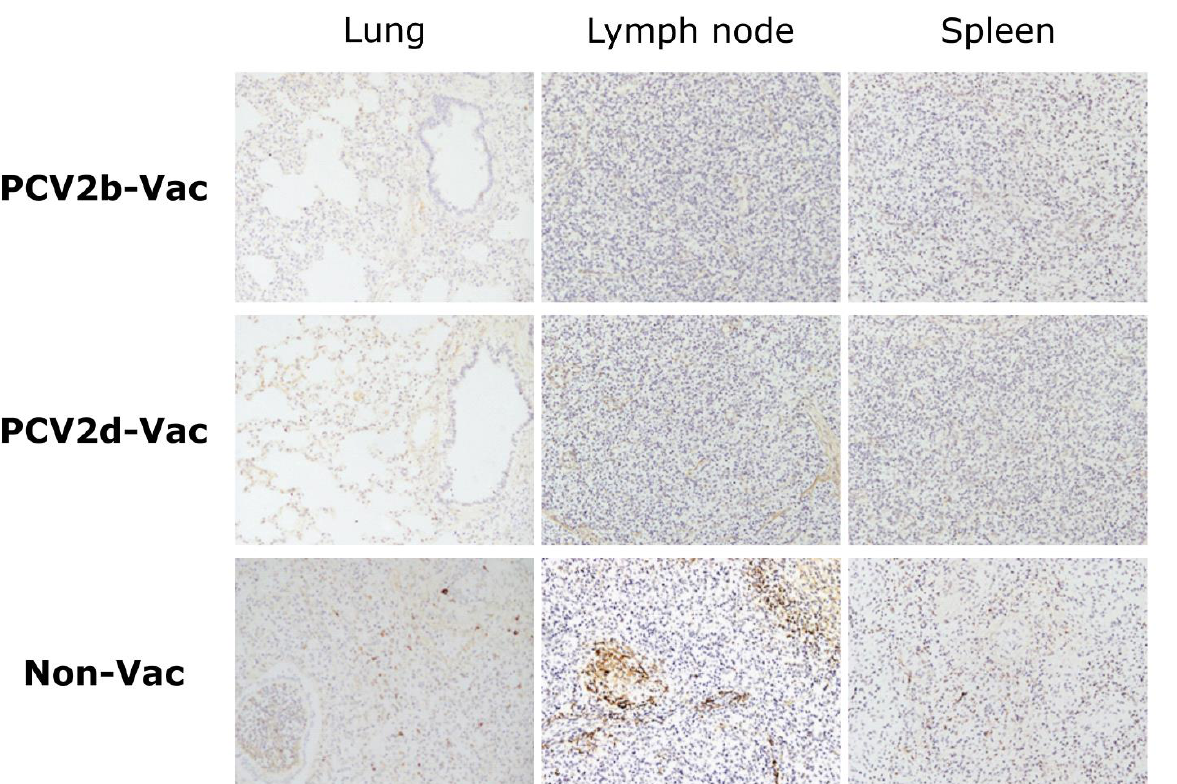
Figure 8. Representative images of immunohistochemistry assessment of PCV2 antigen in lung, lymph node, and spleen from PCV2b-Vac, PCV2d-Vac, and Non-Vac groups in the vaccine efficacy study (Experiment 2). Immunolabeling of PCV2 was observed as a dark brown signal. Magnification: ×400.